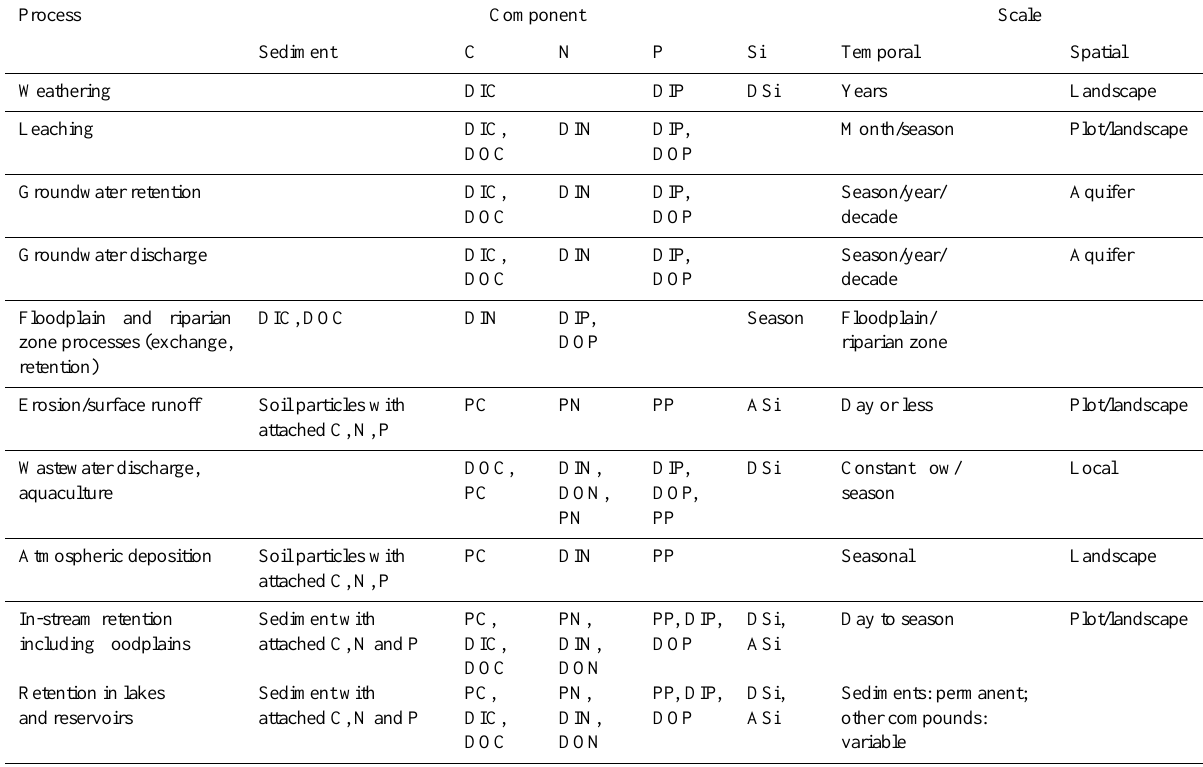
Table 2. Processes responsible for retention and delivery of sediment, carbon (C), nitrogen (N), phosphorus (P),and silicon (Si) to streams, by form a , and the scale at which these processes occur.